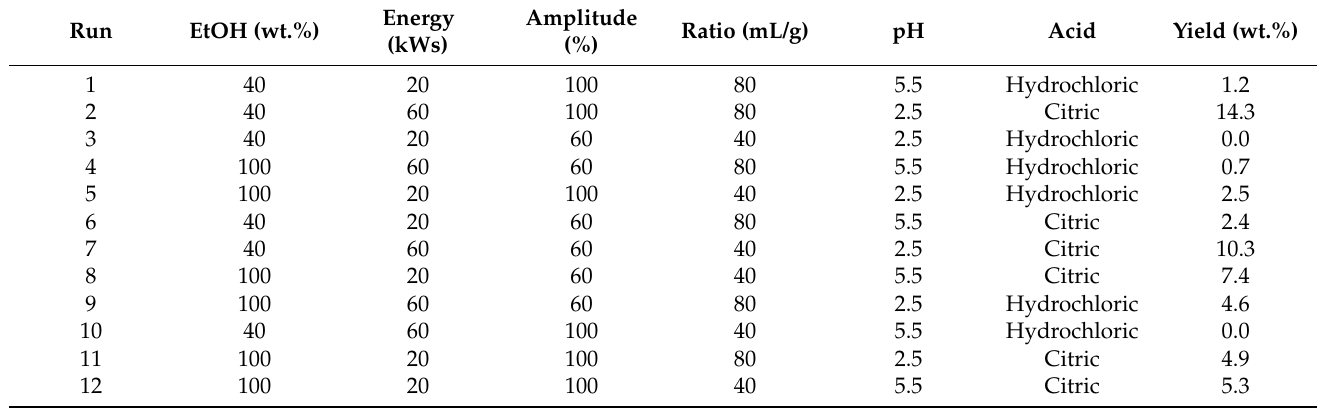
Table 3. UAE results obtained for Plackett–Burman (III) screening design in TP.